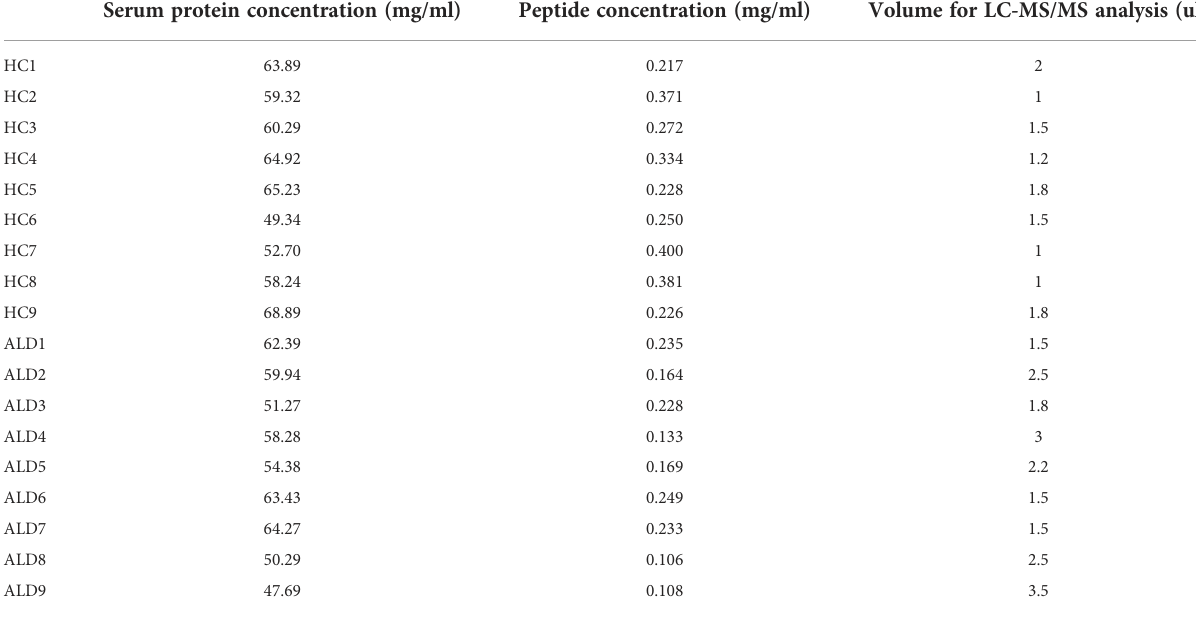
TABLE 1 Serum protein concentration and quality for analysis. Serum protein concentration (mg/ml) Peptide concentration